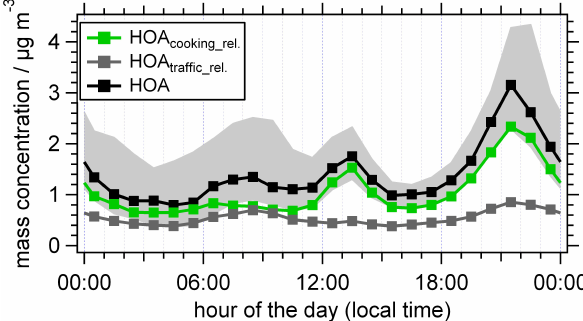
Fig. 2. Diurnal pattern (hourly median values for the whole cam- paign) of HOA from the two-factor solution, and the two HOA-like factors (HOA traffic rel . , HOA cooking rel . ) from the three-factor solu- tion retrieved for the Downtown site. Percentiles (25 and 75%, light grey shading) are only shown for HOA from the two-factor solution for